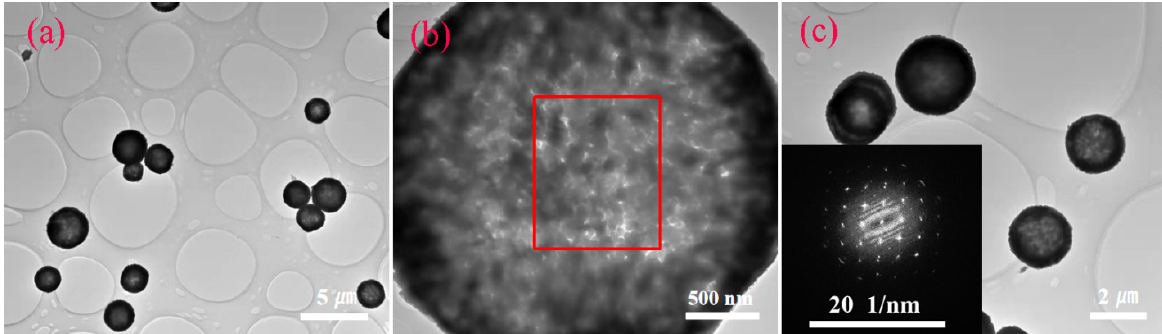
Figure 4. TEM image of pure ZnSnO 3 ( a , b ) and TEM image of Bi-ZnSnO 3 (4 wt%) ( c ); inset is the SAED image ( c ).